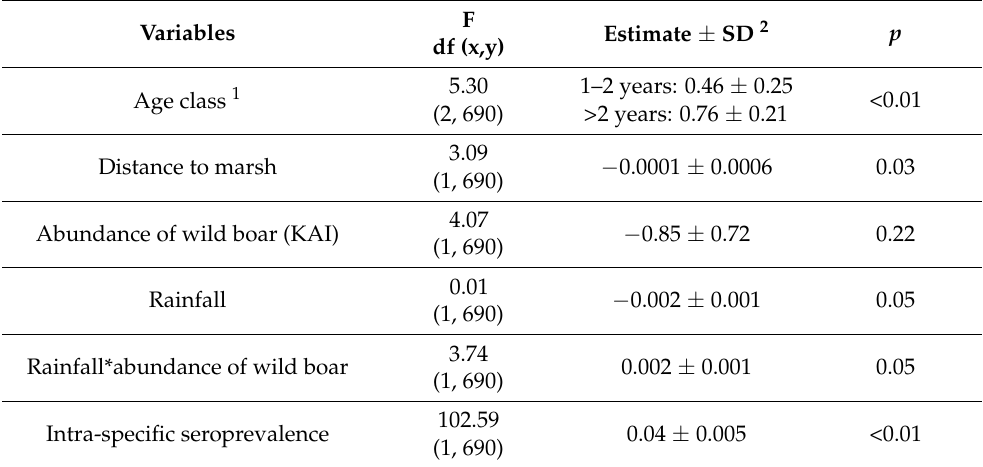
Table 2. Parameters from the best GzLMM for the serological status against HEV in wild boar related to age class, relative abundance (KAI), straight-line distance to the marshland (DMARSH), the rainfall of the previous sampling period (rainfall), the intra-specific seroprevalence of HEV and the interaction between rainfall and KAI.